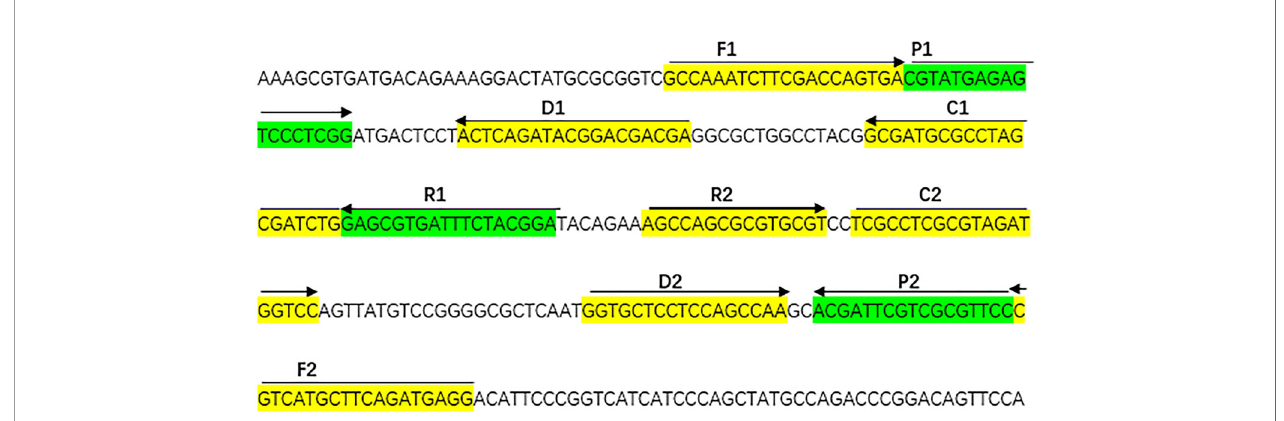
FIGURE 1 | The sequences, positions and modi fi cations of the Aspergillus fumigatus -speci fi c gene annex ANXC4 , Right arrows and left arrows indicate sense and complementary sequences that were used in the study.